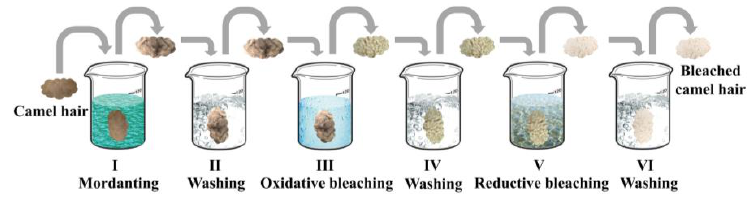
Figure 1. Simulation of experimental procedures.